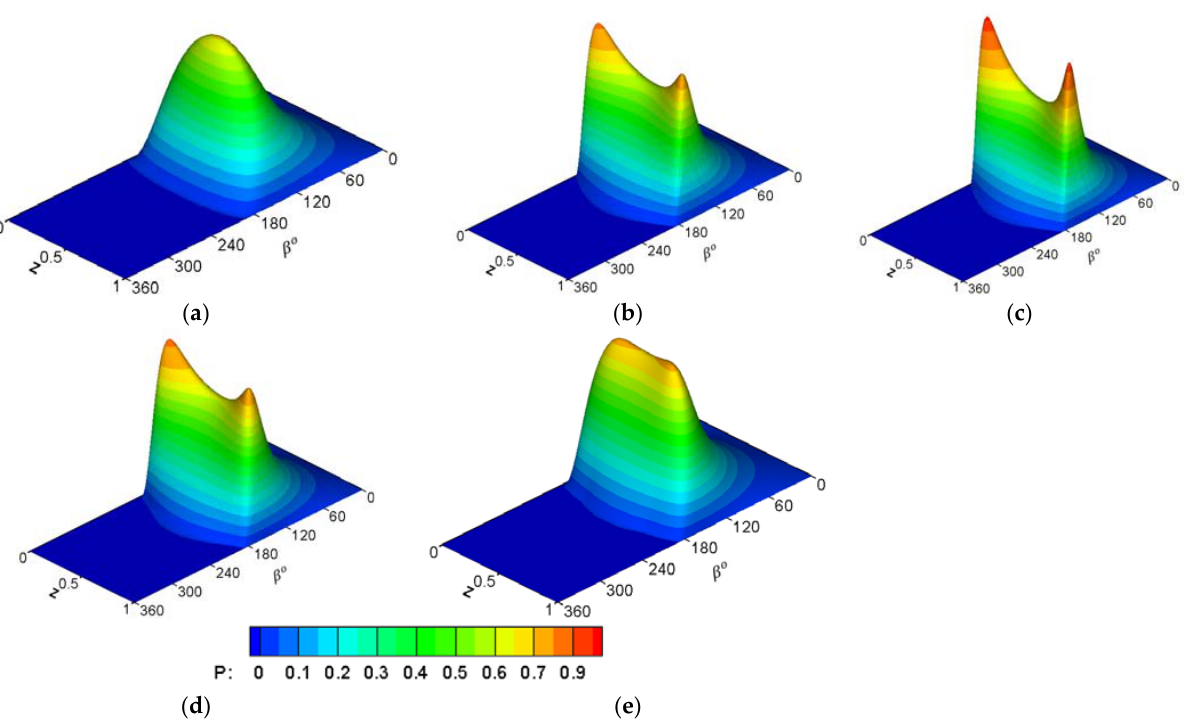
Figure 5. Effect of bearing chamfer on the dimensionless pressure distribution (L/D = 1.25). ( a ) ∆ℎ (cid:3042) (cid:3404) ∆𝑣 (cid:3042) (cid:3404) 0 , ( b ) ∆ℎ (cid:3042) (cid:3404) ∆𝑣 (cid:3042) (cid:3404) 0.55 , ( c ) ∆ℎ (cid:3042) (cid:3404) ∆𝑣 (cid:3042) (cid:3404) 0.58 , ( d ) case ( c ) with chamfer ( 𝐴 (cid:3404) 𝐵 (cid:3404) 0.1 ) and ( e ) case ( c ) with chamfer ( 𝐴 (cid:3404) 𝐵 (cid:3404) 0.25 ).